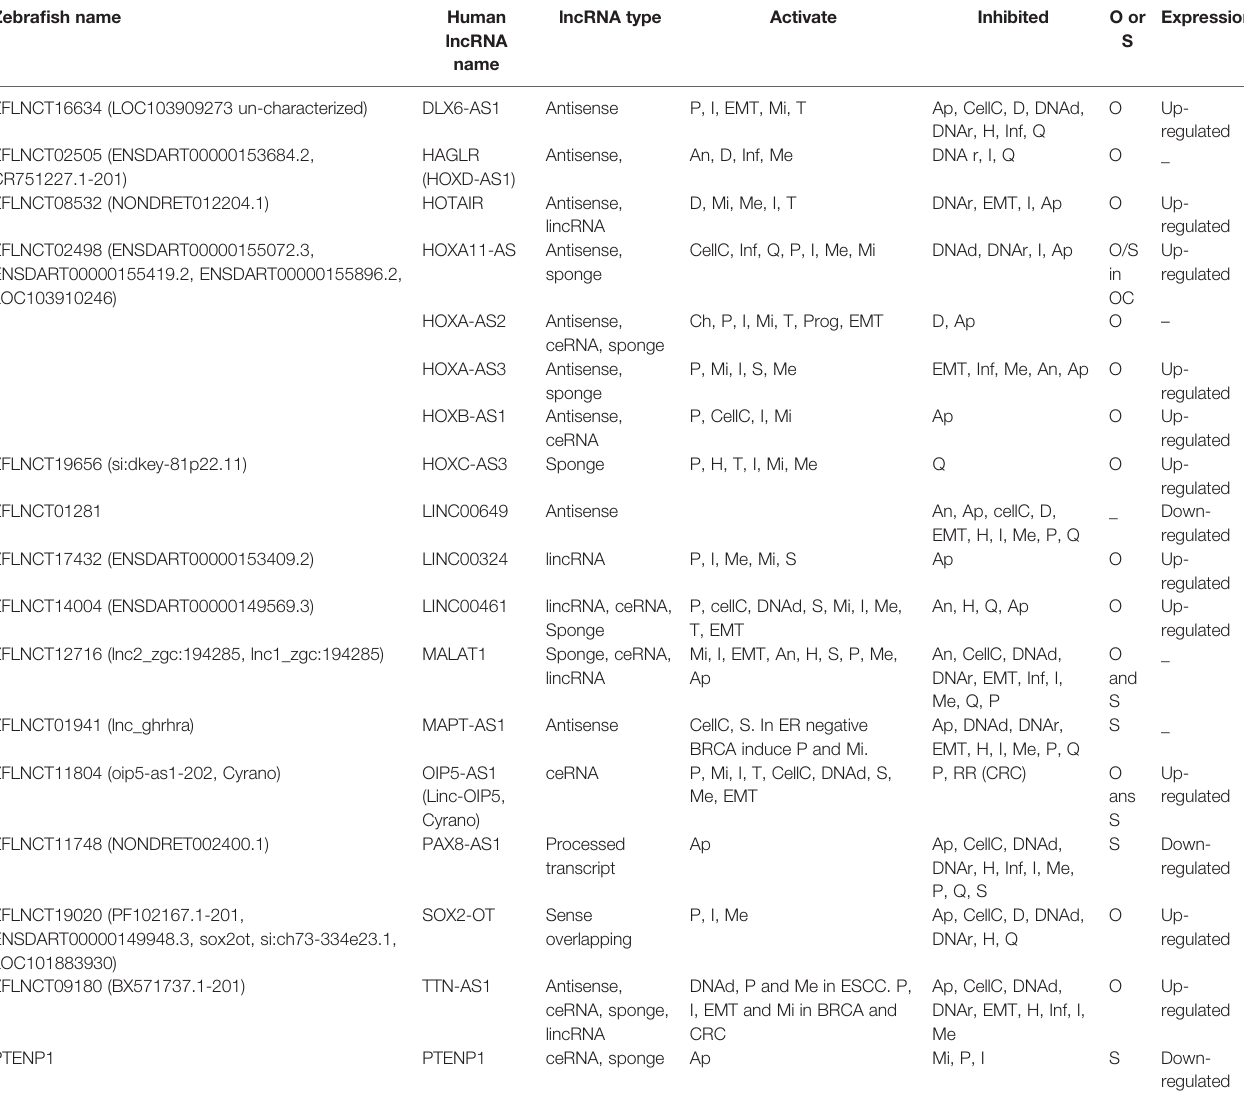
TABLE 2 | Functional relationship between conserved lncRNAs and breast cancer